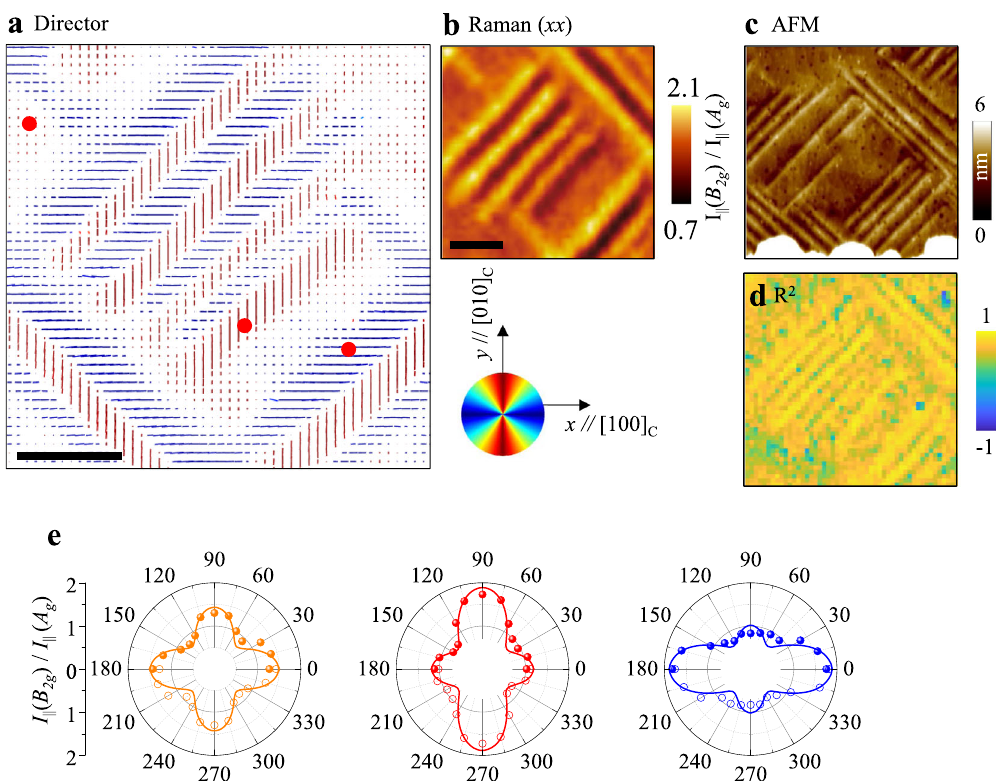
Fig. 4 Real-space visualization of the JT domains. a A director map obtained by position-sensitive angle-resolved Raman spectroscopy. b Representative Raman map of the B 2g mode normalized by the A g mode measured in the ( xx ) polarization geometry. c AFM image and d R 2 map over the same region. e Fitting curves for three representative points, denoted by red spots in a . All scale bars are 1 μ